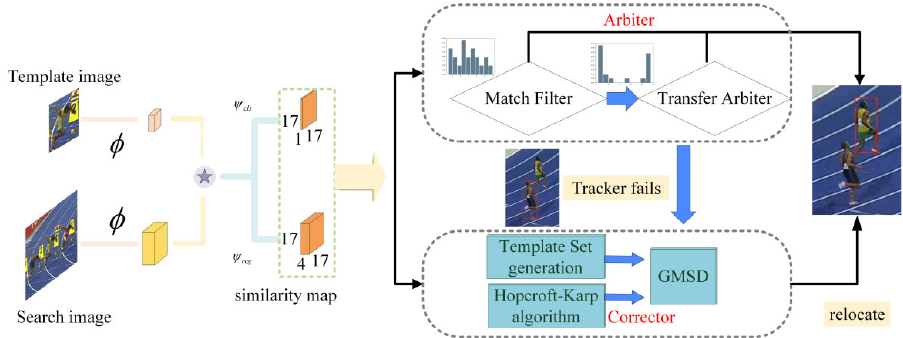
Figure 1. Framework of the proposed tracker architecture.